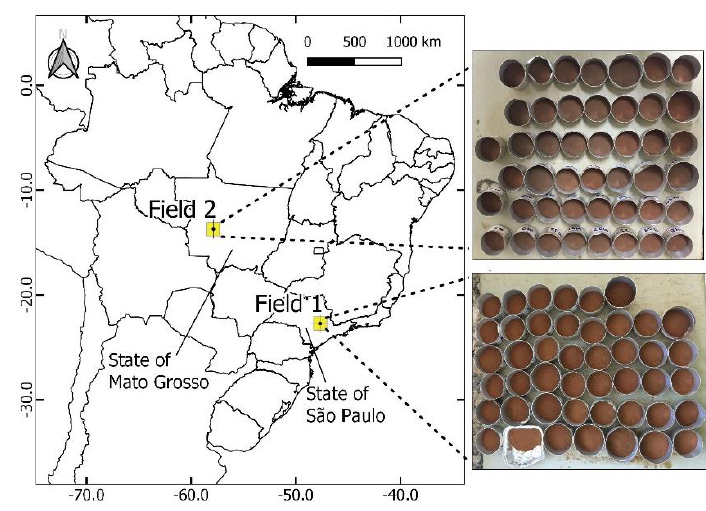
Figure 1. Location of Field 1 and Field 2 in Brazil, where the soil samples were collected.